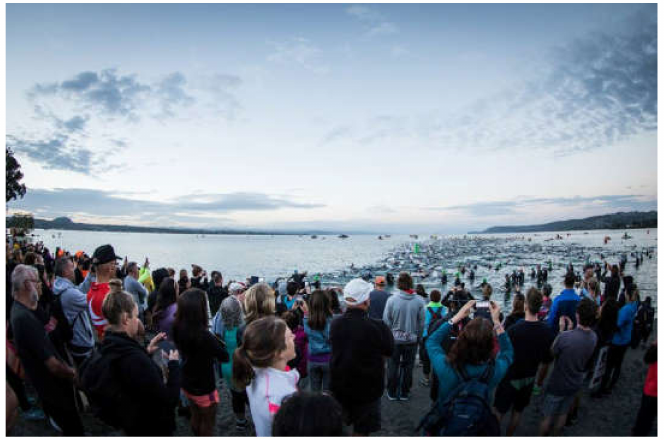
Figure 5. The swimming stage of an Ironman event 3.8 km, Lake Taupo, New Zealand (38.7 ◦ S 176.1 ◦ E) 3 March 2018. Open swimming environments present no shade for competitors who are placed in a prone position for the duration of the